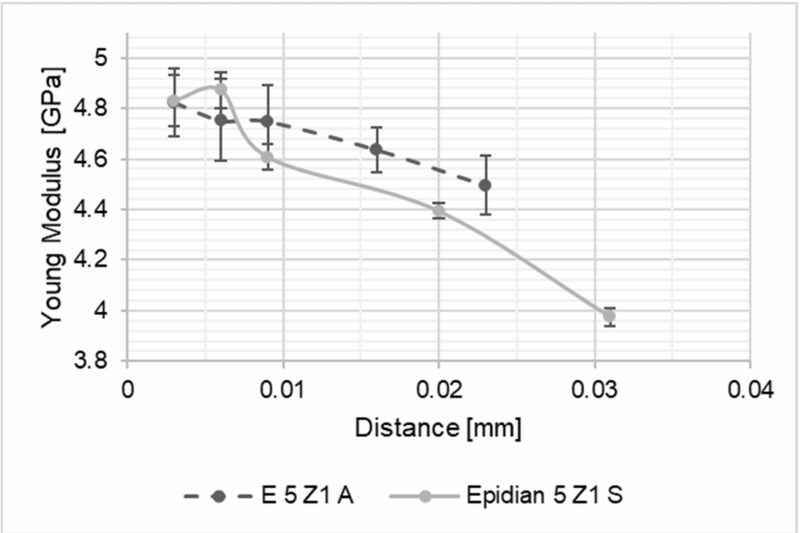
Figure 5. Comparison of Young’s modulus values for the Epidian 5/Z1 joint bonding: A—aluminium alloy sheets; S—stainless steel sheets, as